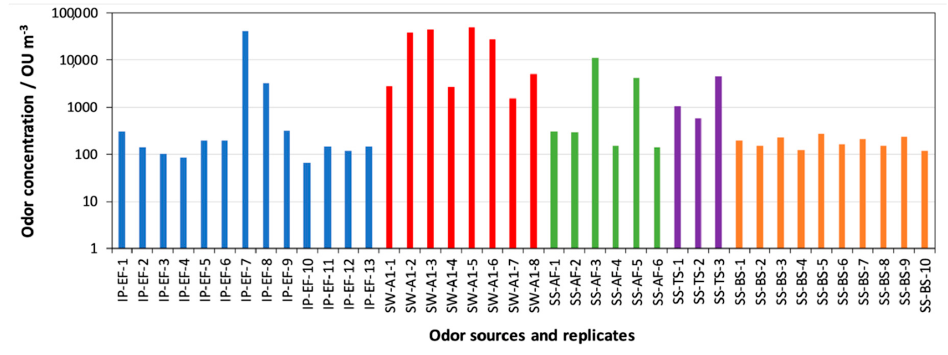
Figure 4. Odor concentrations (in OU m − 3 on a logarithmic scale) for selected sources (Figure 3) determined using dynamic dilution olfactometry.